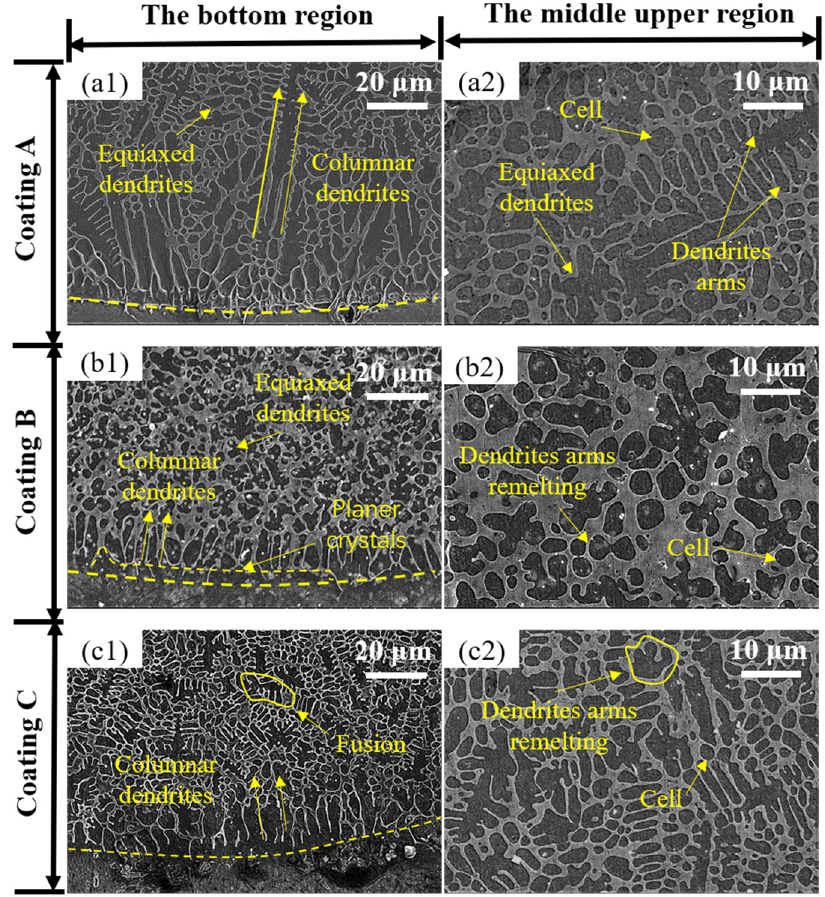
Figure 4. The microstructure of coatings at the bottom ( a1 – c1 ) of coatings A (0 mT), B (20 mT), C (40 mT) and in the middle upper region ( a2 – c2 ) of coatings A (0 mT), B (20 mT), C (40 mT). As seen in Figure 4b1, the size of columnar dendrites decreased gradually and the proportion of equiaxed dendrites increased in the bottom of coating B. Moreover, all of the columnar dendrites were separated from the bright planar crystal. The Lorentz force (F L ) generated by EF aggravated the Marangoni convection (MC) at the bottom, which increased the stress at the root of the twin columnar dendrites, causing the fracture and formation of the independent fine columnar dendrites. Figure 5a shows the columnar dendrite fracture mechanism under EF, and Figure 5b shows its schematic diagram.